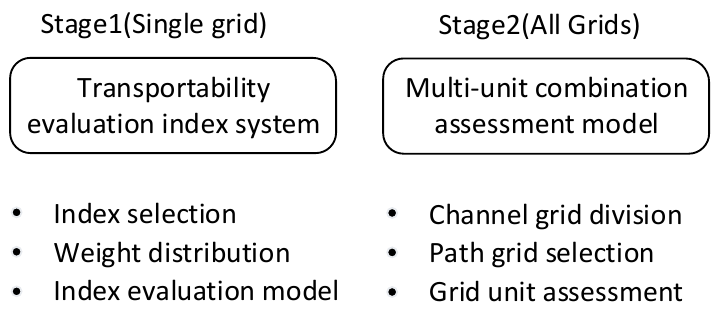
Figure 4. Brief stage process of transportability assessment framework.